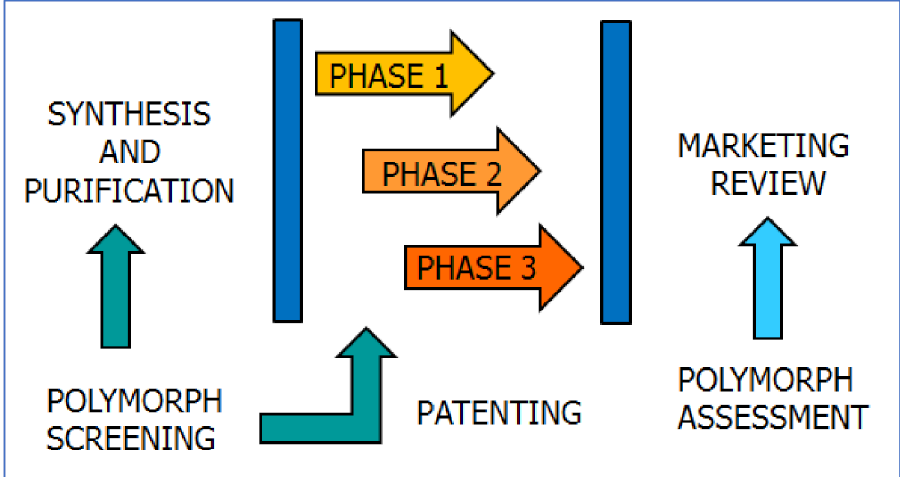
Figure 13. A flow-chart showing how polymorph screening ought to be associated with the API selection, before entering trial stage, and the quality control process, once the API is on the